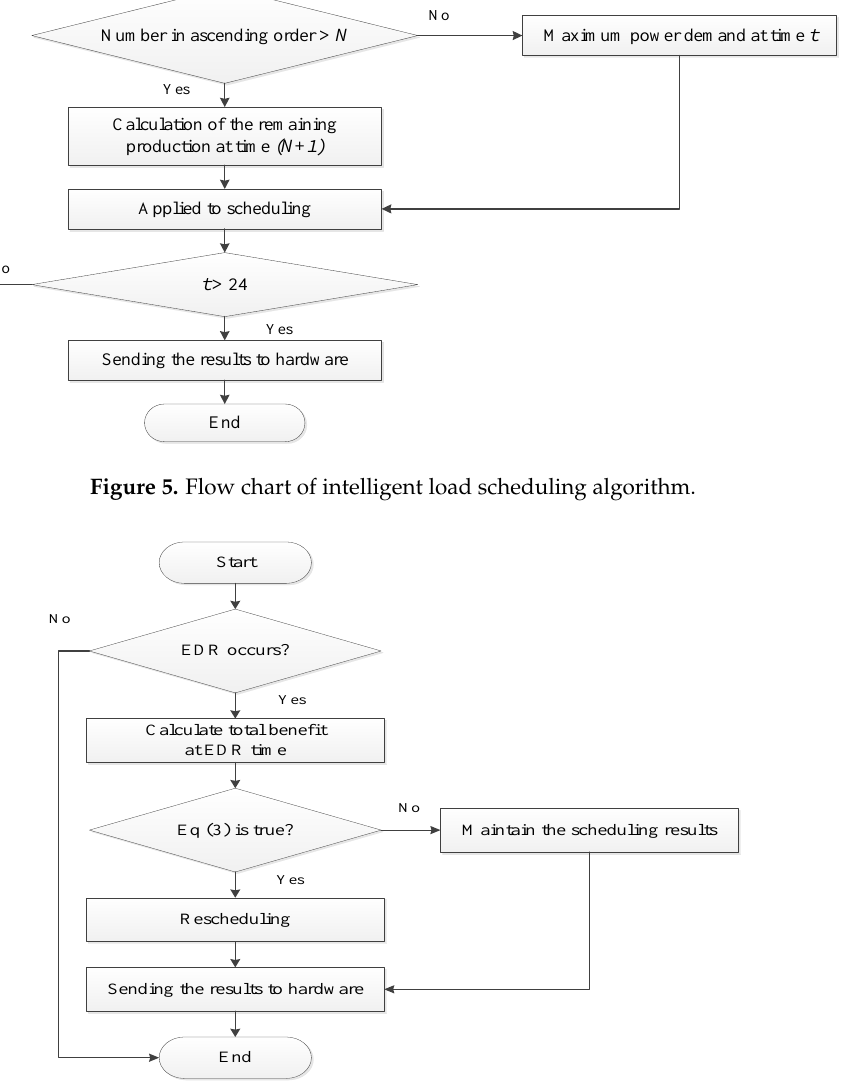
Figure 6. Flow chart of intelligent load real-time algorithm.